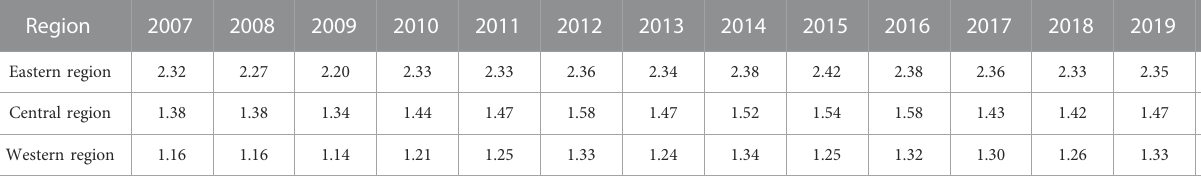
TABLE 5 Score of the operating DB environment from 2007 to 2020. Region